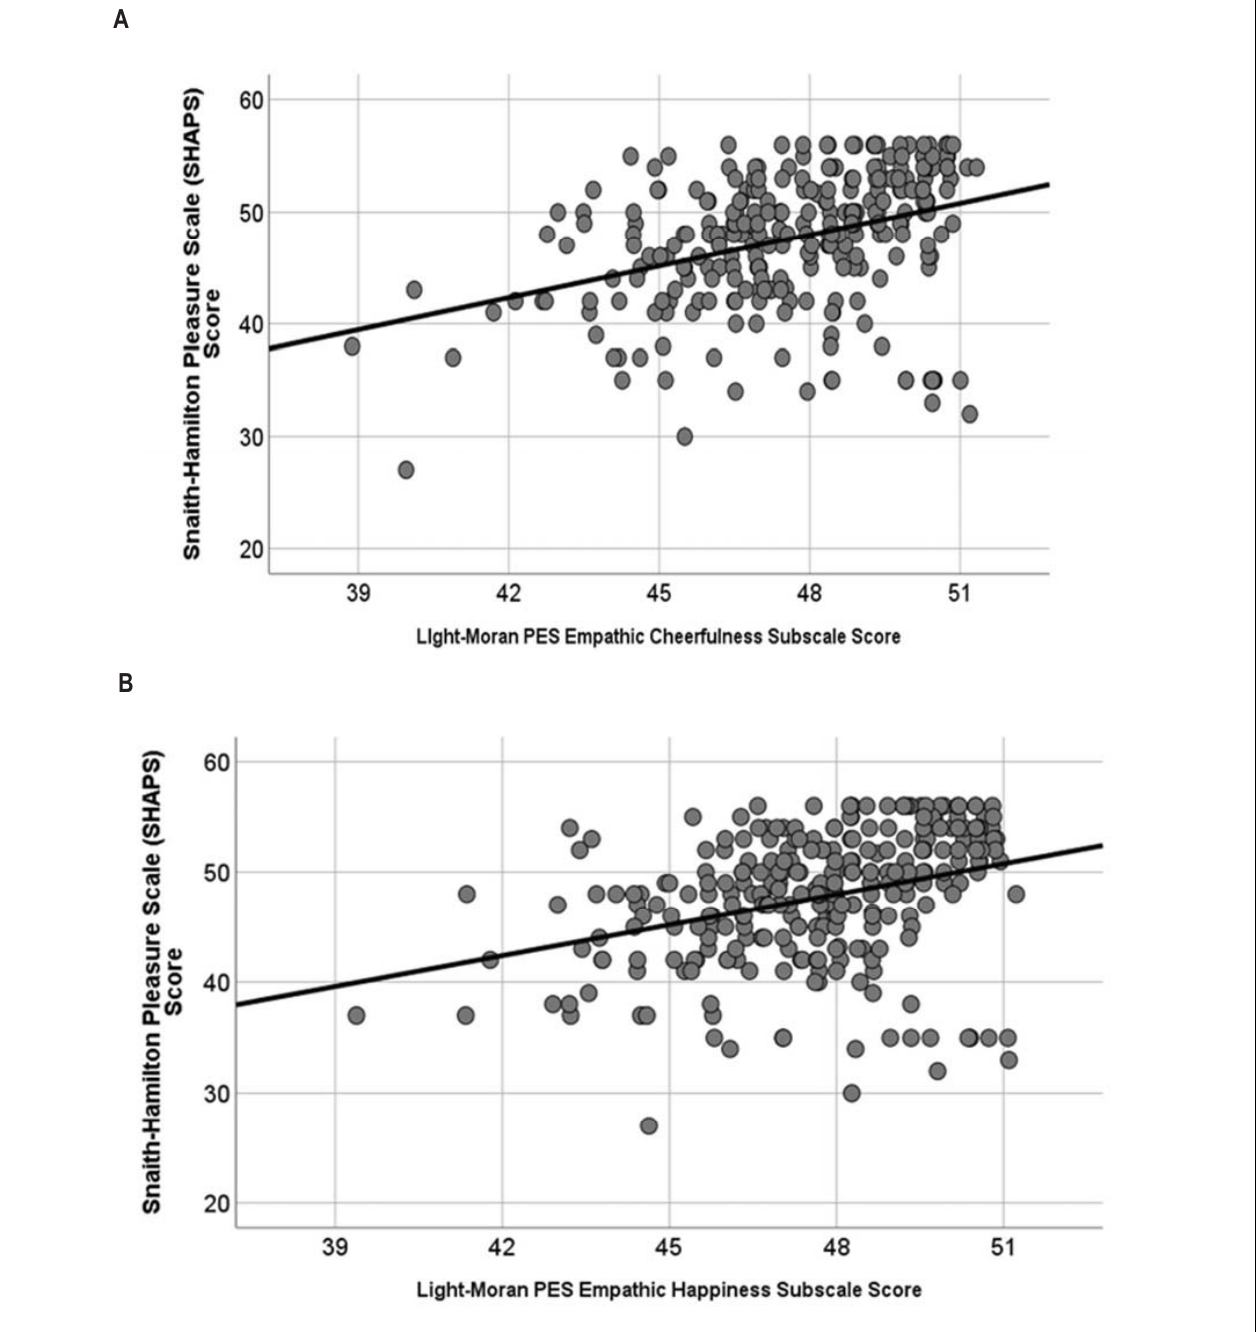
FIGURE 1 | (A) Empathic cheerfulness [ R 2 = 15%, F (2,279) = 24.28, p < 0.001] and (B) empathic happiness [ R 2 = 12%, F (2,279) = 19.59, p < 0.001] were about equally predictive of anhedonia score (measured via the SHAPS).